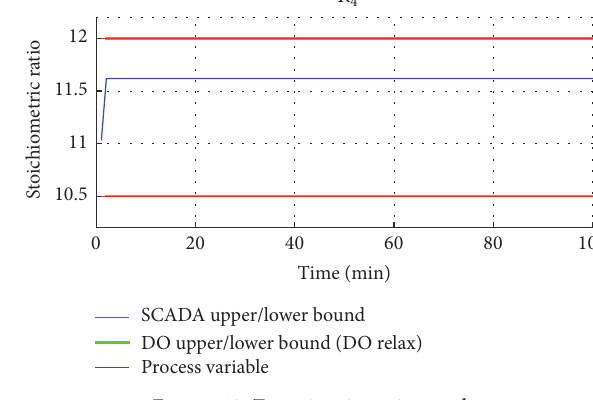
Figure 13: Zone 4 stoic. ratio trends.